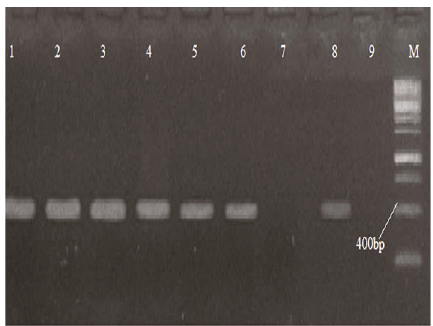
Figure 4: Amplified PCR products of selected Fragaria species of the ITS2 marker and 1kb DNA